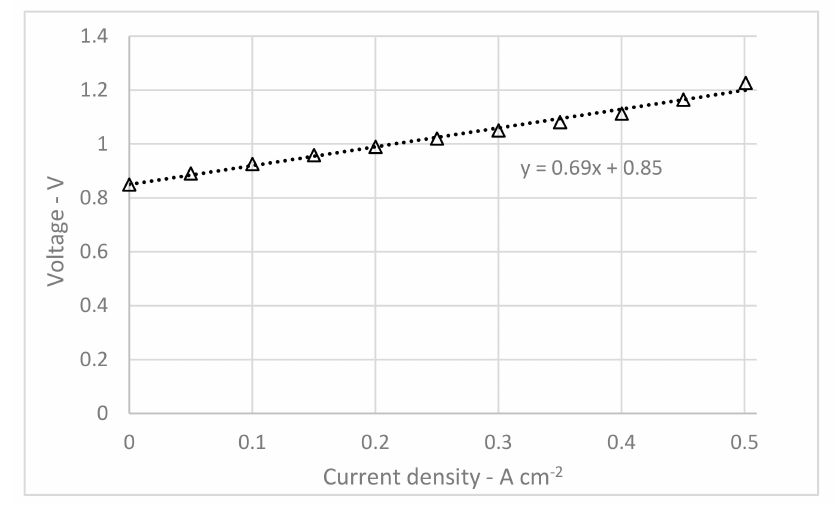
Figure 5. Polarization curve obtained from the experimental test at 750 ◦ C. Table 3. Test condition of the polarization